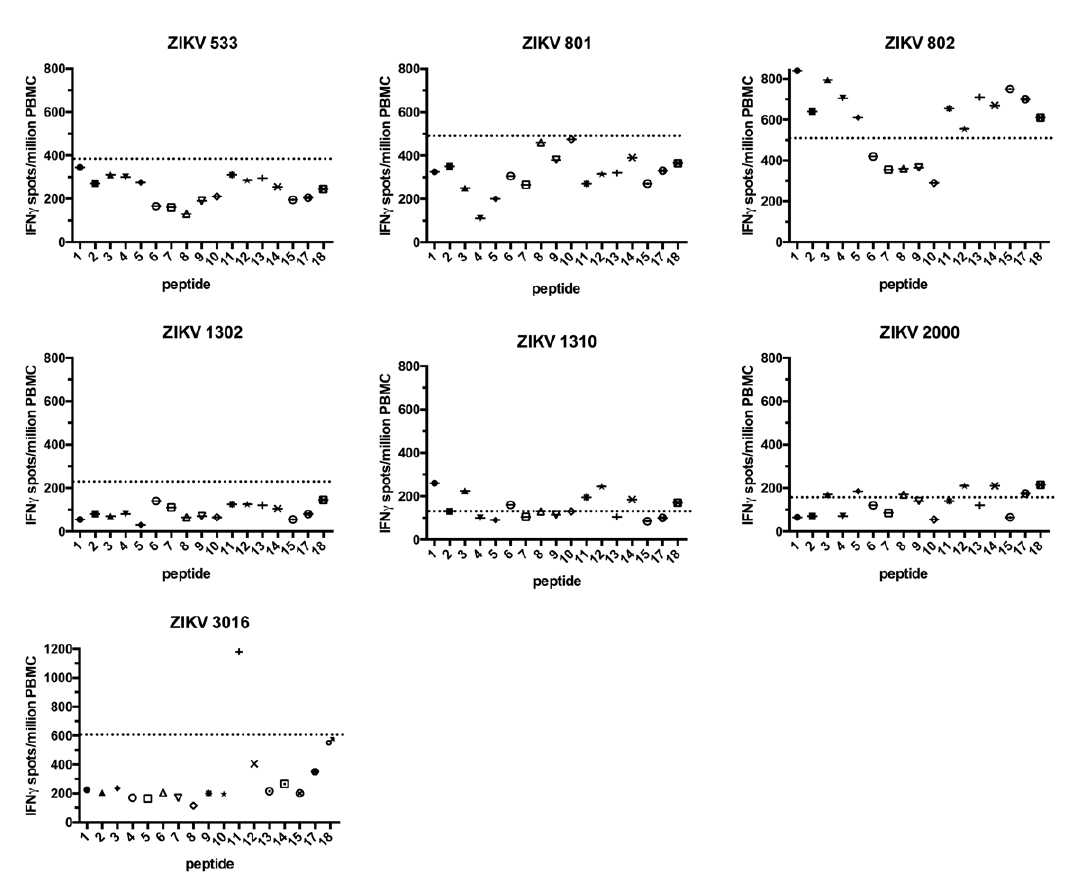
Figure 2. Identification of ZIKV Epitope. PBMCs from ZIKV-infected subjects were stimulated with peptides 1-18 and IFN γ production was evaluated by ELISPOT. The dashed line represents the background level of IFN γ in the absence of stimulation multiplied by